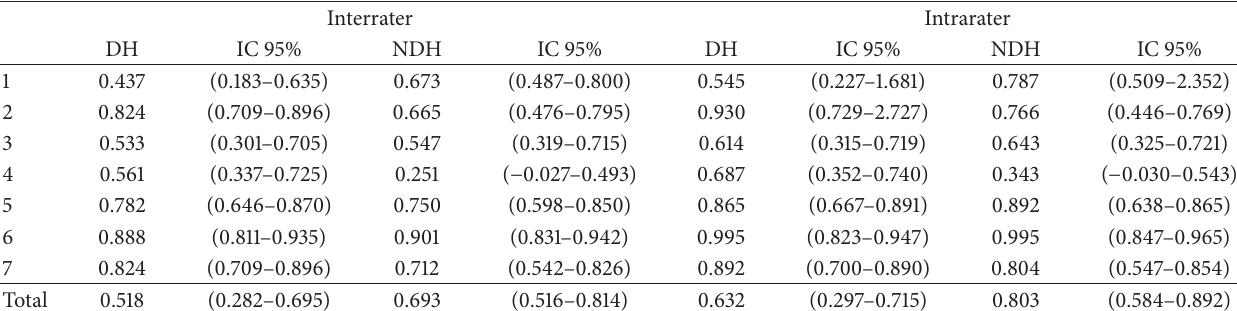
Table 2: Interrater/intrarater reliability for dominant hand and nondominant